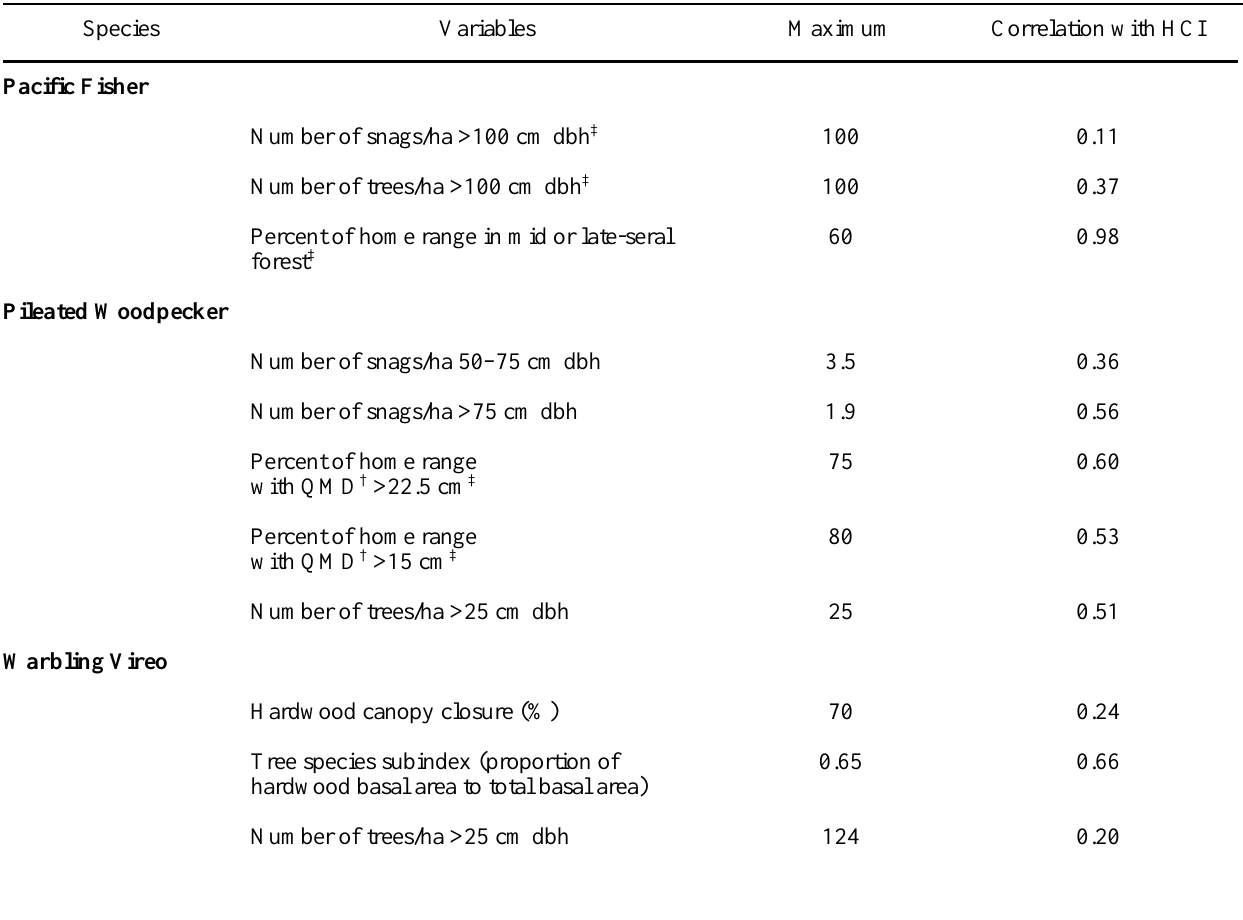
Table 1. Variables used in habitat capability indices of focal species, Oregon Coast Range. Maximum is the value or range of the variable at which the index score is set equal to 1. The correlation values represent the rank order correlation between each variable data set and the HCI data set. Rank is assigned by ordering the data from lowest to highest. Details of each model are given in Appendix A for the Pacific Fisher, in Appendix B for the Pileated Woodpecker and in Appendix C for the Warbling Vireo. † QMD = quadratic mean diameter, i.e., diameter of the tree with the average basal area, ‡ Distance around focal pixel that is evaluated for landscape effects (see Appendices for